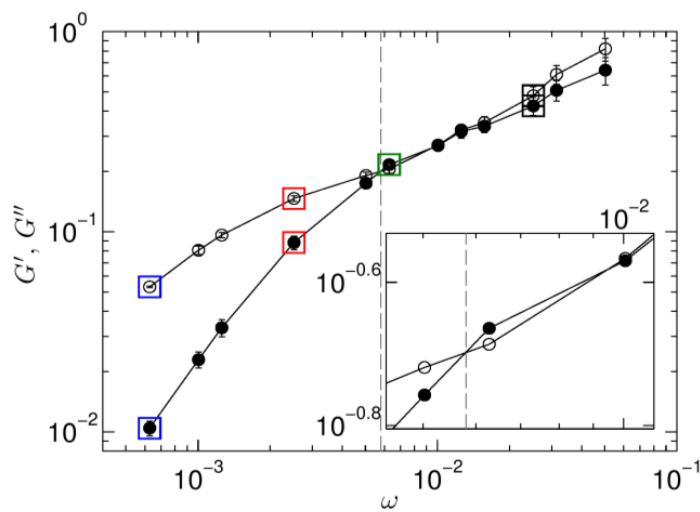
Figure 2. The frequency dependence of the loss (open symbols) and storage moduli (closed symbols) obtained at a strain rate of 𝛾̇ = 2.26 × 10 −3 . The crossover frequency where 𝐺 ′′ = 𝐺′ is marked by a dashed gray line. Data are reported as the average of the primary harmonic as determined at each period of oscillation. Error bars are the standard deviation in this data. The inset shows a closer view near the crossover frequency. Four frequencies are identified within the frequency range as square symbols. The coloring scheme remains consistent throughout the manuscript.